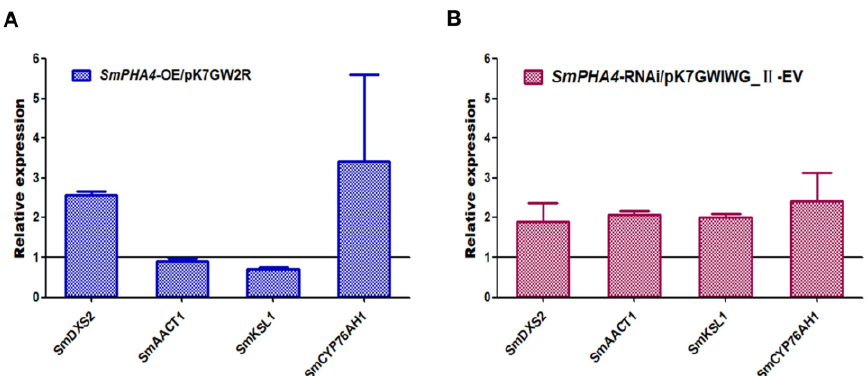
Figure 5. Transcriptional expression analysis in S. miltiorrhiza transgenic hairy root lines. The transcriptional expression levels of tanshinone biosynthesis pathway genes were detected by qRT-PCR. The average transcriptional expression level of each gene in the two control hairy root lines was set to 1. SmActin was used as the internal reference gene. Error bars represent the SD of three biological replicates. ( A ) The transcriptional expression levels of tanshinone synthesis-related enzyme genes in SmPHA4-OE transgenic hairy root lines. ( B ) The transcriptional expression levels of tanshinone synthesis-related enzyme genes in SmPHA4-RNAi transgenic hairy root lines.